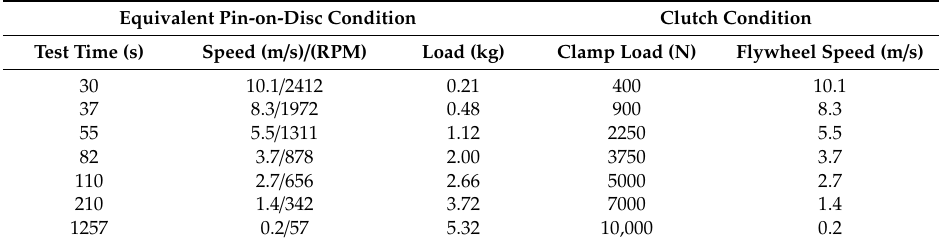
Table A1. Comparison of clutch engagement conditions with the equivalent pin-on-disc tests.